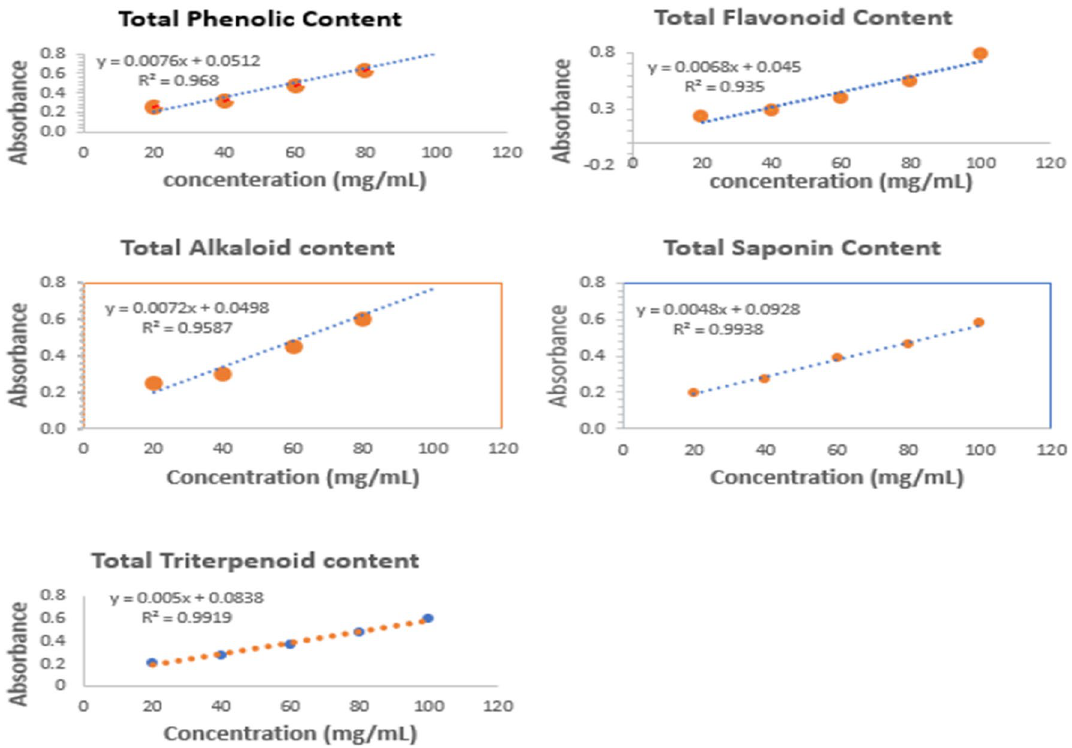
Fig. 1 Total content present in Luffa cylindrica (L.)